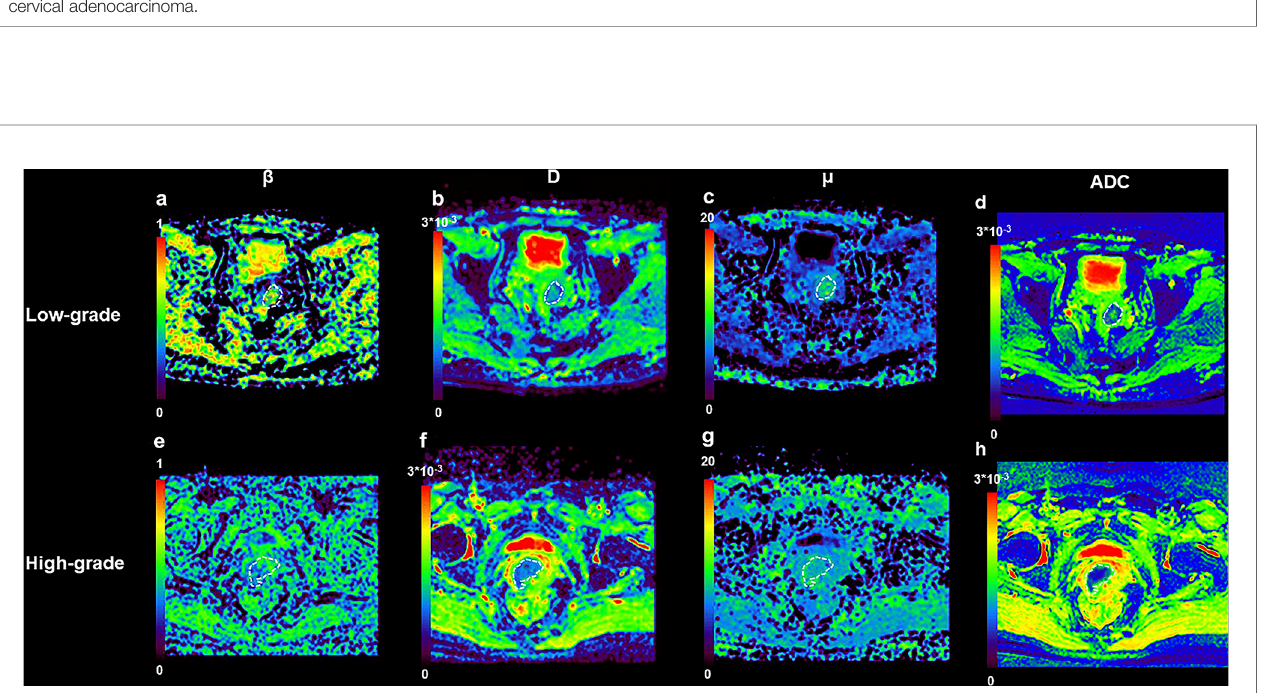
FIGURE 3 | An example of low-grade tumor from a 53-year-old patient and high-grade from a 64-year-old patient. (A) b map for patient with low-grade tumor; (B) D map for patient with low-grade tumor; (C) m map for patient with low-grade tumor; (D) ADC map for patient with low-grade tumor; (E) b map for patient with high-grade tumor; (F) D map for patient with high-grade tumor; (G) m map for patient with high-grade tumor; (H) ADC map for patient with high-grade